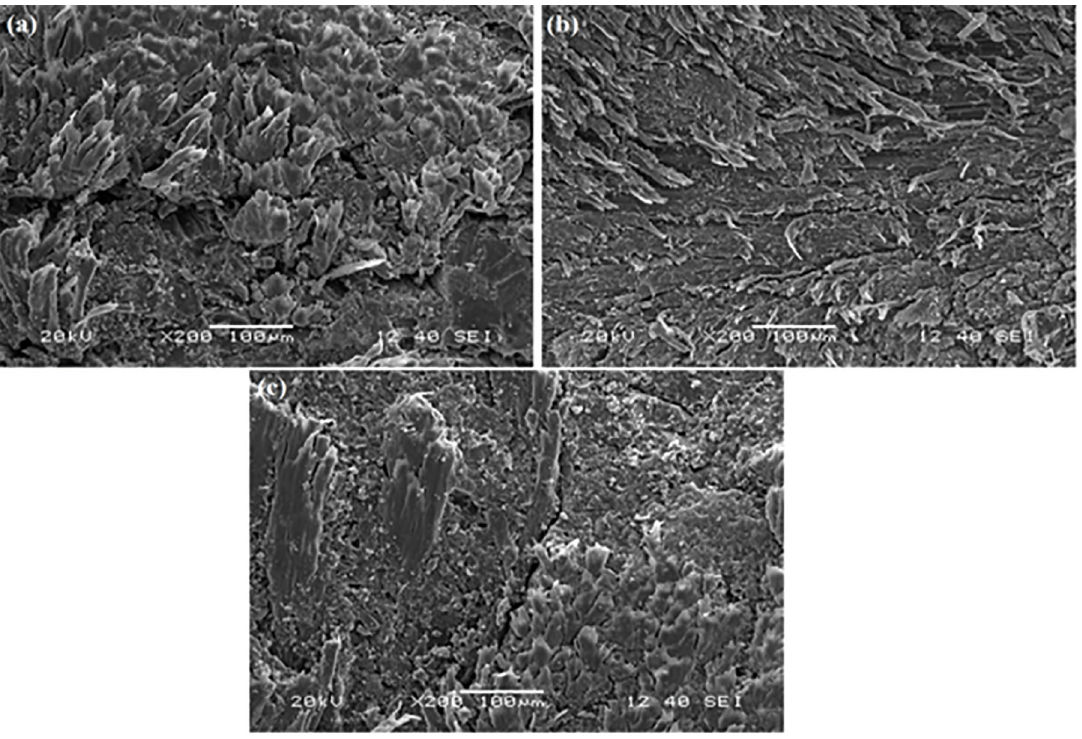
Figure 6. SEM images of (a) Untreated (b) Alkali treated and (c) Benzoyl chloride treated composite surfaces after three body abrasion at 30 wt.% of fiber loading subjected to Normal load of 40 N. Figure 5 and 6 represents the composites with low load chloride composite) when tested at sliding distance of 80 (10N) and high load (40N) with 30 wt.% of fiber loading. m. In figure 8(a) represents the untreated composites with Smooth grooves with few surface cracks in different regions. Micro-ploughing is considered by the formation of deep grooves in wear mechanism and material removal found. In the case of alkali treatment in Figure 8(b), minimization of grooves are found. With the comparison of Figure (a) (b) and (C), Figure 8(c) is depicting good wear resistance and have minimum specific wear rate. In this figure damage of damage dominating. Figure 7 and 8 indicates the composites with low sliding distance (50m) and sliding distance (80m) with 30 wt.% of fiber loading. With the comparison of all the cases, it